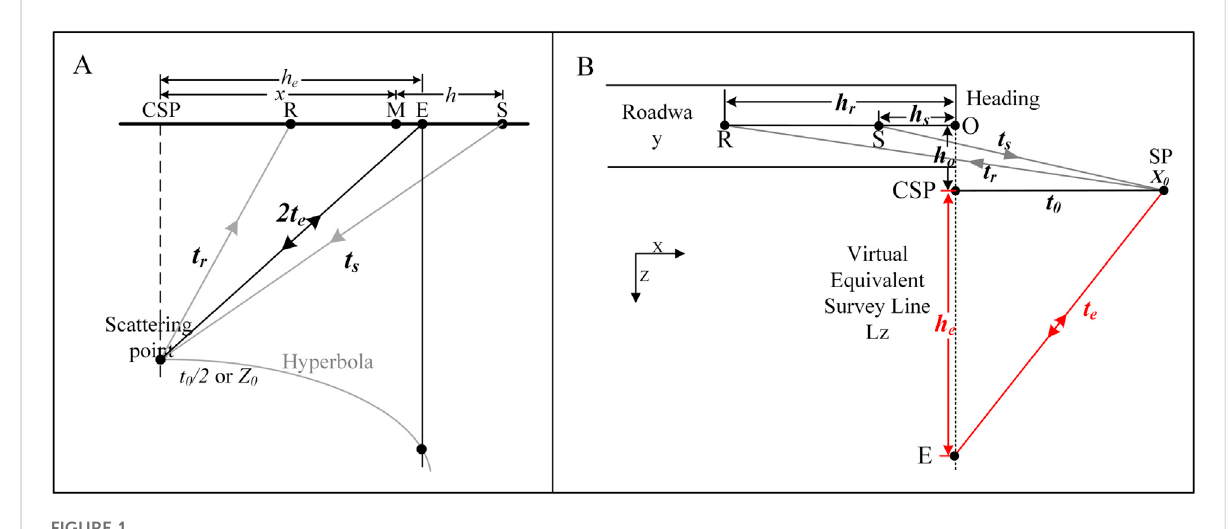
FIGURE 1 Schematic diagram of equivalent offset. (A) Conventional diagram; (B) Improved